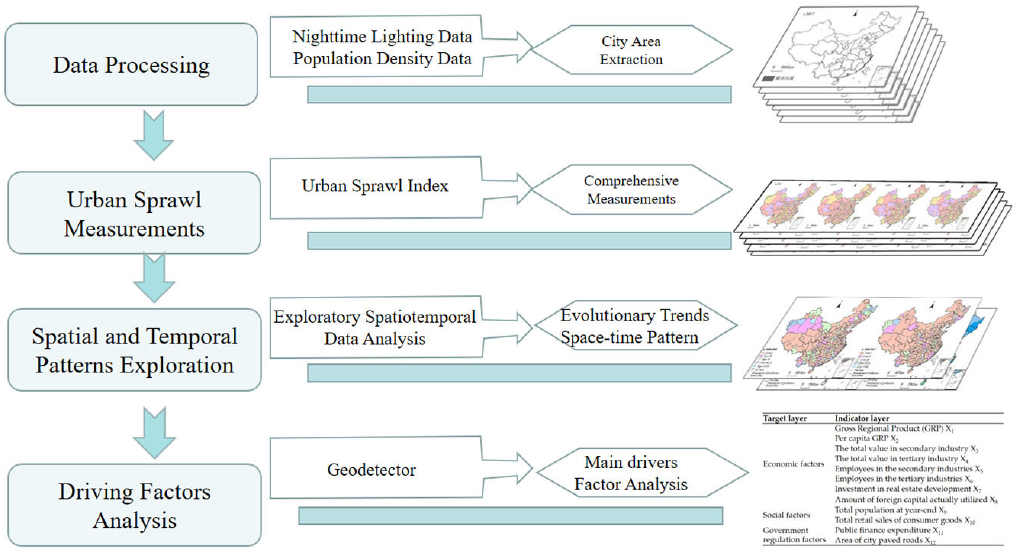
Figure 1. Flow process